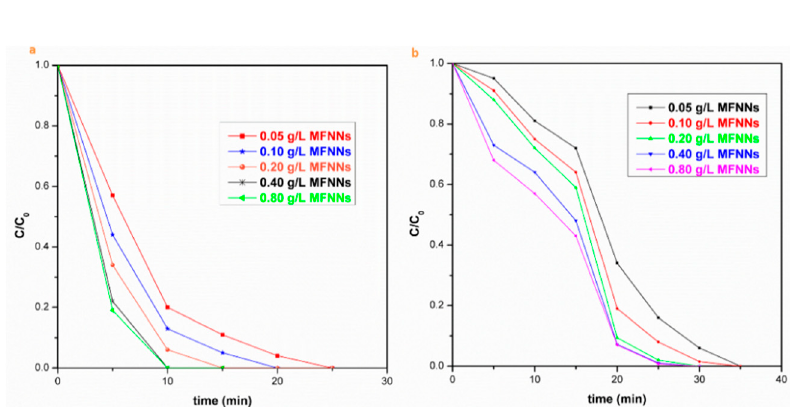
Figure 9. Effect of MFNN dosage on the simultaneous removal of ( a ) Cr(VI) and ( b ) 4-CP. (Experiment conditions: [Cr(VI)] 0 = 10.0 mg/L, [4-CP] 0 = 100.0 mg/L, [H 2 O 2 ] 0 = 4.90 mM, pH = 3.0).